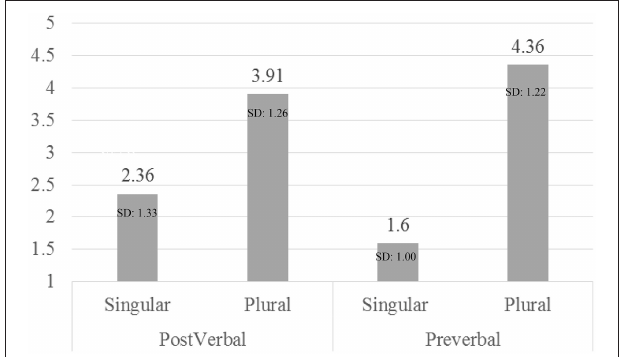
FIGURE 1 | Acceptability judgment task—number and subject